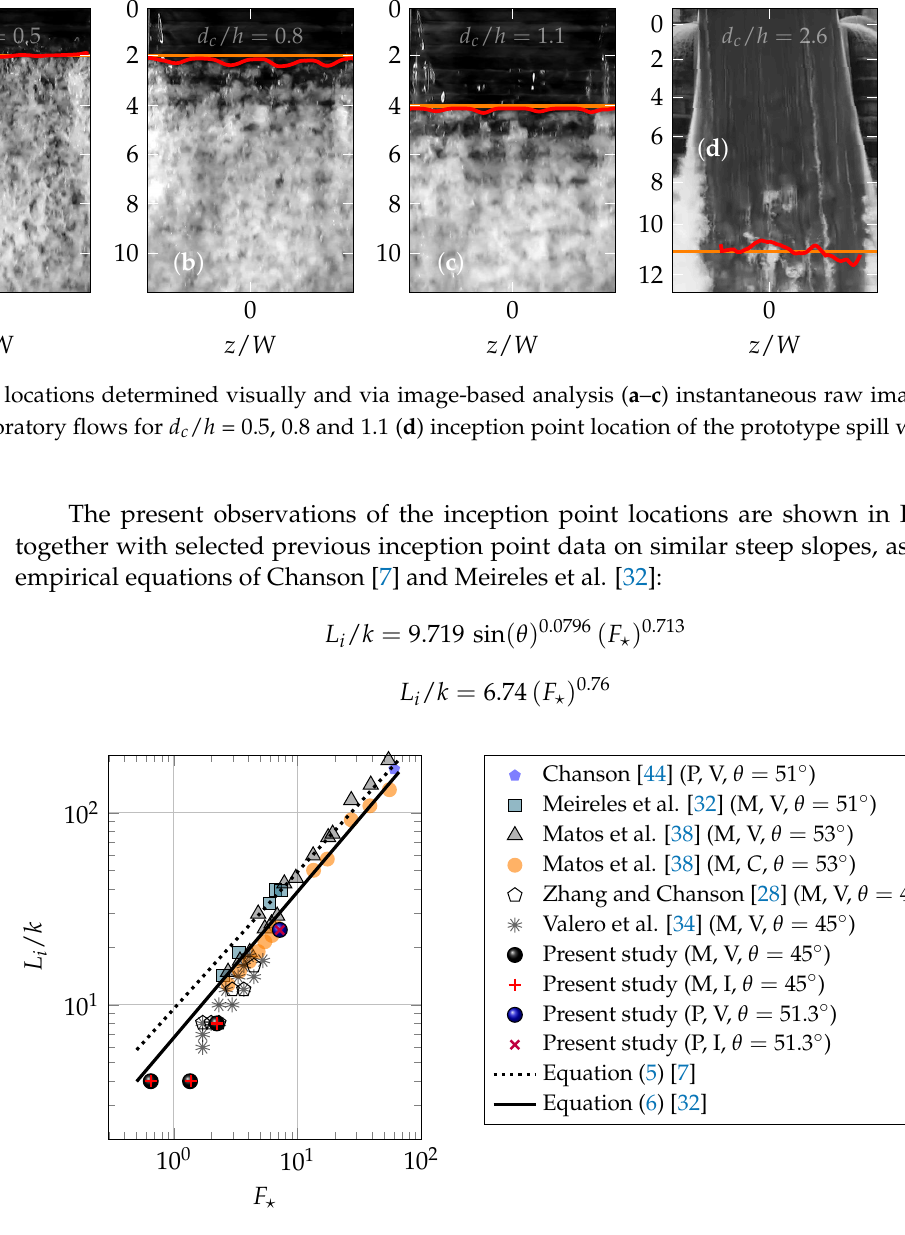
Figure 3. Inception point of free-surface aeration—comparison of inception point locations (present study) with literature data with similar slopes; P = prototype, M = model, V = inception point visually determined, C = inception point determined based on air concentration measurements, I = inception point determined via image-based analysis (present study)